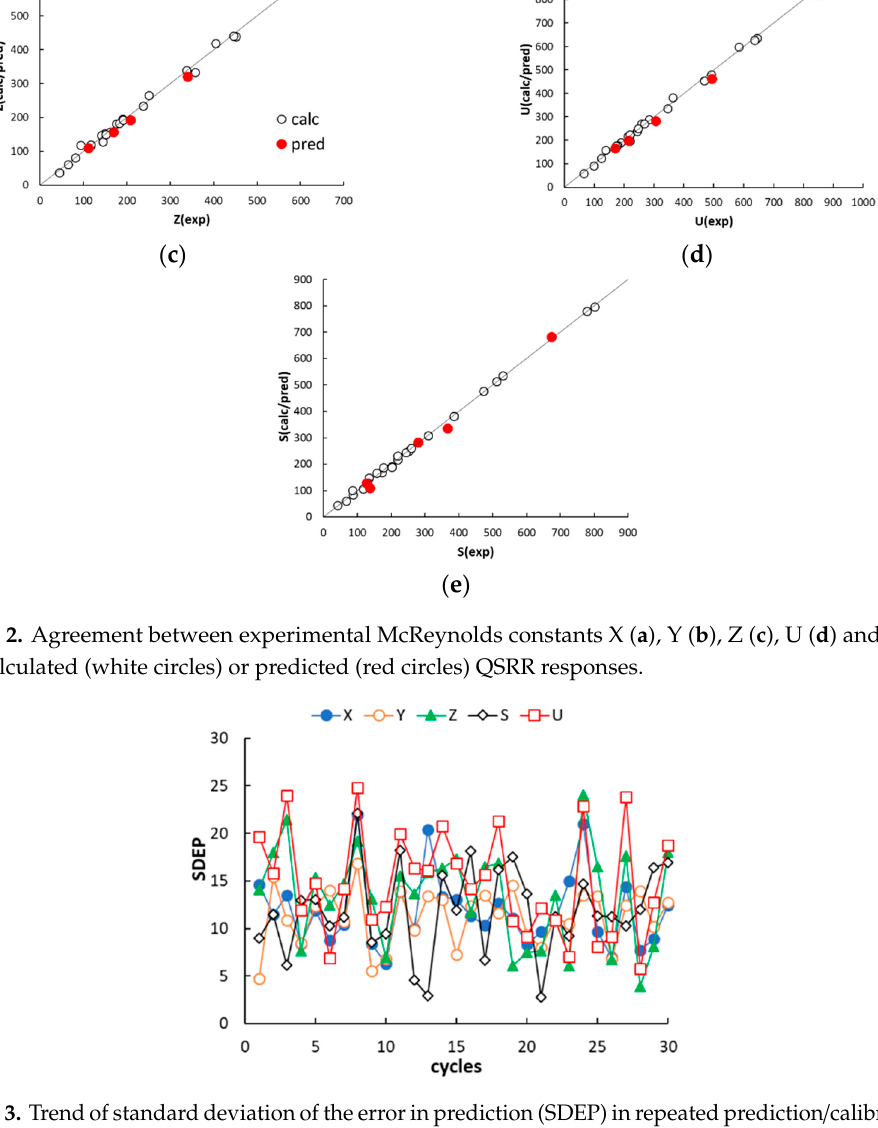
Figure 3. Trend of standard deviation of the error in prediction (SDEP) in repeated prediction/calibration random partitions of Monte Carlo validation.